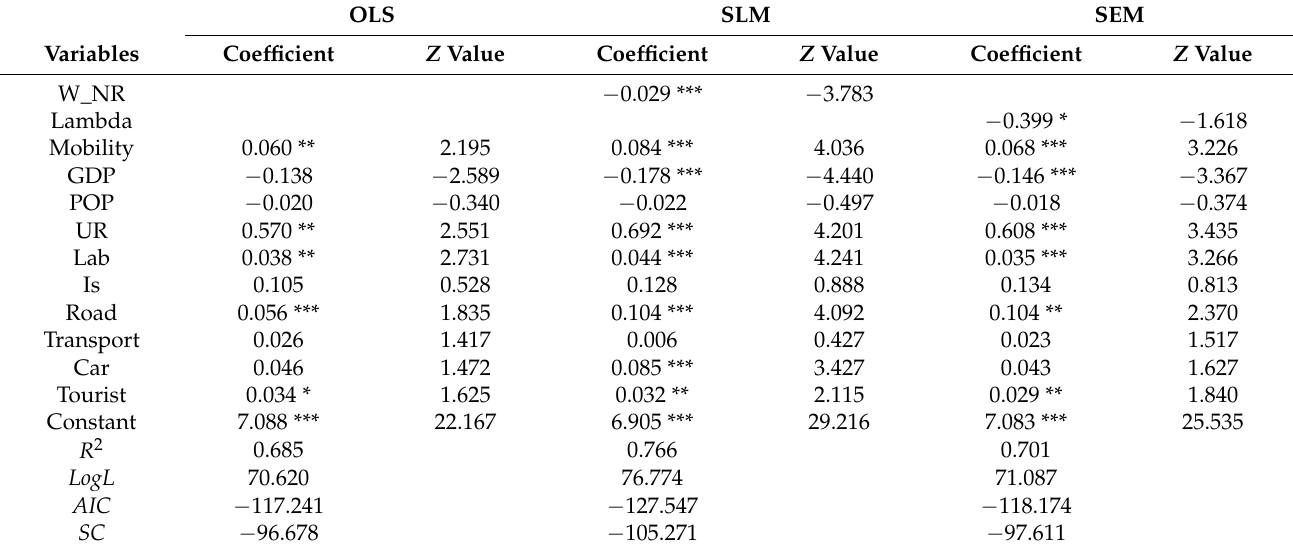
Table 4. Spatial econometric model results for network